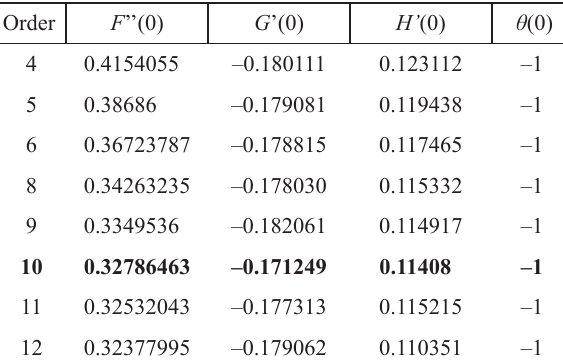
Table 1 – Convergence of HAM series solution